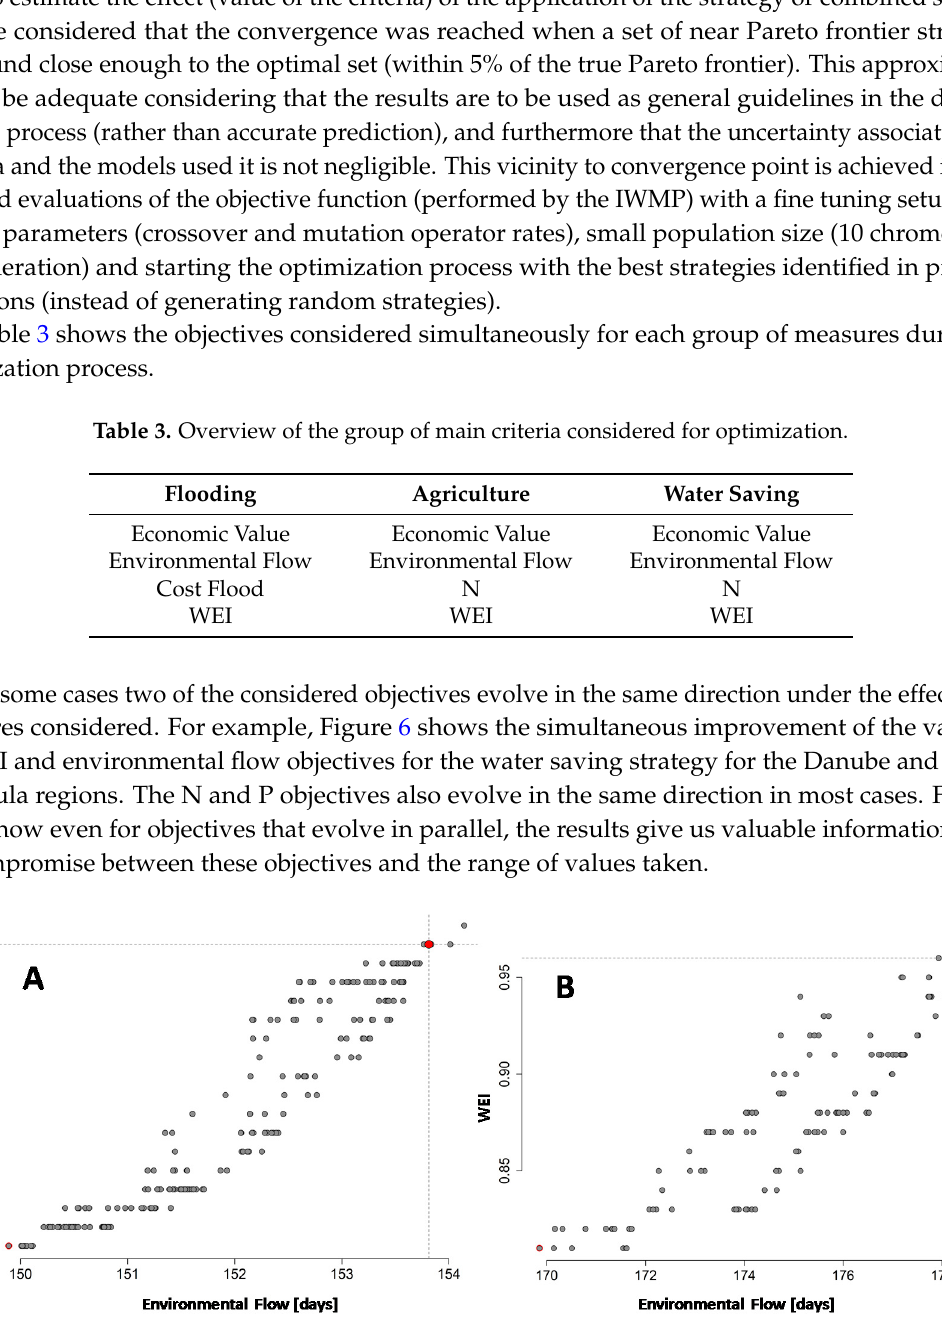
Figure 6. Strategies obtained according to WEI and environmental flow criteria considering the water saving family of measures for the Danube catchment ( A ) and the Mediterranean side of the Iberian Peninsula ( B ). The red point corresponds to the baseline 2030 strategy.